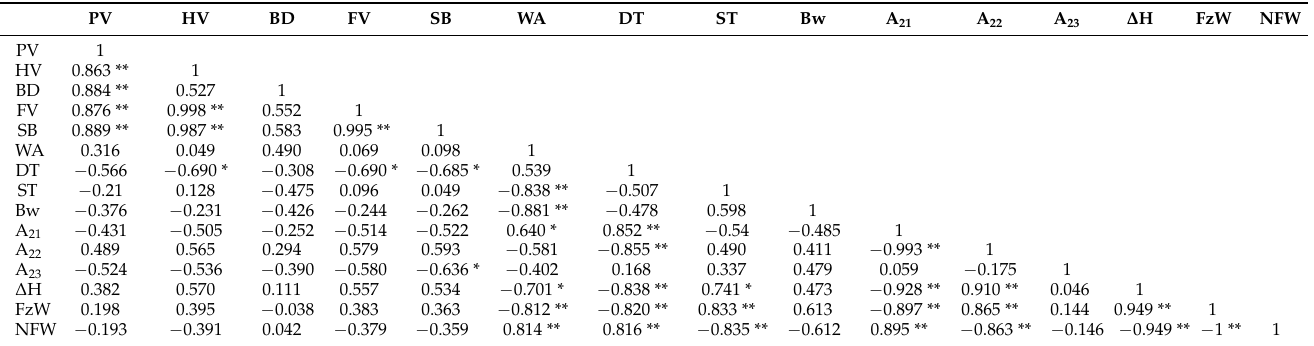
Table 7. Correlation